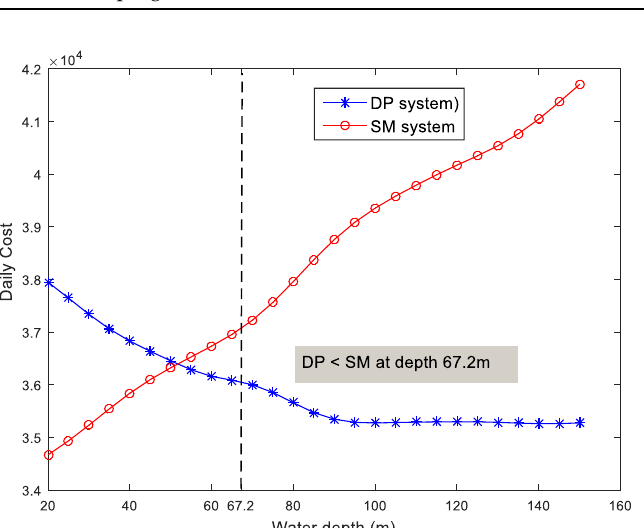
Figure 14. Decision making by ANNs based on total operational cost for the project specified in Table 12.